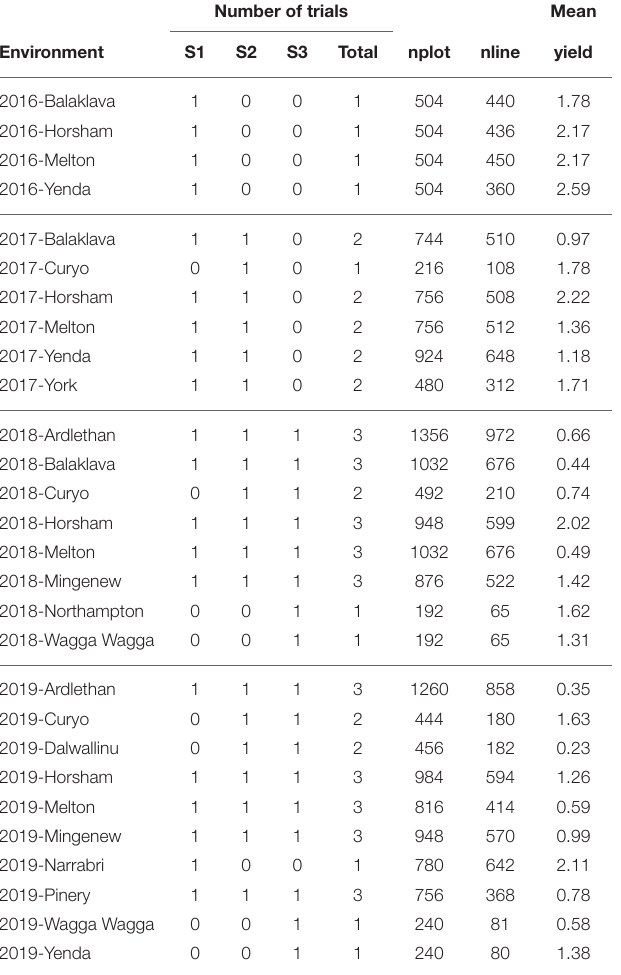
TABLE 11 | Summary of environments in the chickpea MET dataset: number of trials for each stage of testing (S1, S2, S3) and total number of trials. Number of trials Mean